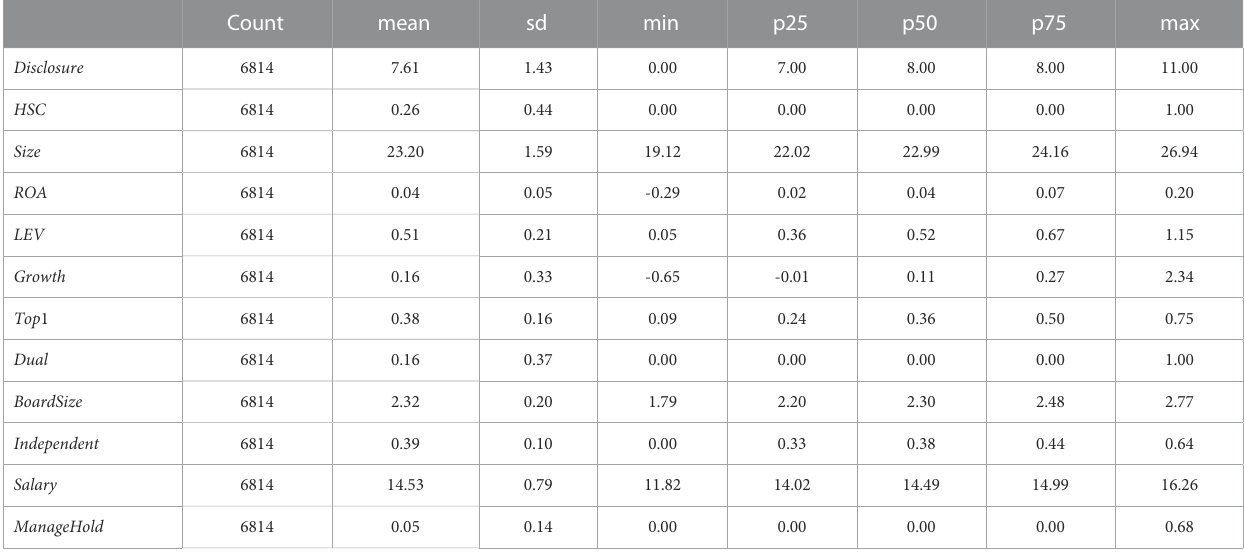
TABLE2Summarystatistics:Thistablepresentsthesummary statistics ofkeyvariablesinthispaper.ThemainsamplecoversallChineseA-sharelistedcompanies spanning from 2006 to 2019. Firms in the fi nancial industry, ST or *ST fi rms, and fi rms with missing ESG disclosure data are excluded. The dependent variable, Disclosure ,isaproxy variableof thelevel of corporate ESGdisclosure. Itiscalculated by scoringthe fi rm ’ s disclosure of ESG-relatedinformation. Theindependent variable, HSC , is an indicator variable that equals 1 if fi rm i enters the Shanghai-Hong Kong or Shenzhen-Hong Kong Stock Connect target stock list in year t , and 0 otherwise. The control variablesinclude fi rm-level characteristics measured at the end of year t -1: fi rm size ( Size ), return on total assets ( ROA ), fi nancial leverage ( LEV ), operating income growth rate ( Growth ), ownership concentration ( Top 1), integration of two positions ( Dual ), board size ( BoardSize ), independent director ratio( Independent ),topthreeexecutive ’ scompensation( Salary ),andmanagementshareholding ratio( ManageHold )(Hope,2003;Wang,2016;Wangetal.,2019). The detailed variable de fi nitions are in Table 1. All continuous variables are winsorized at 1% and 99%